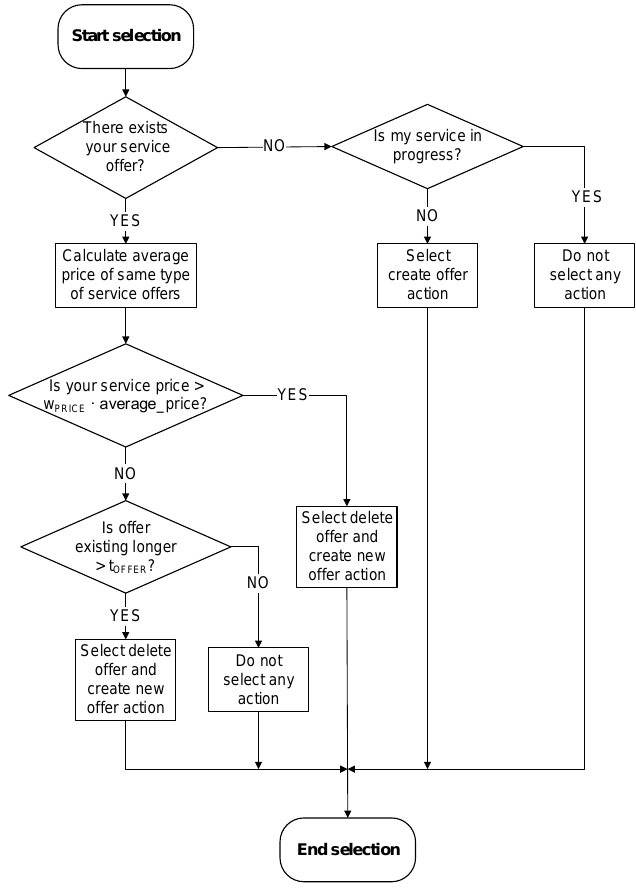
Figure 11. Flowchart of the service action decision-making